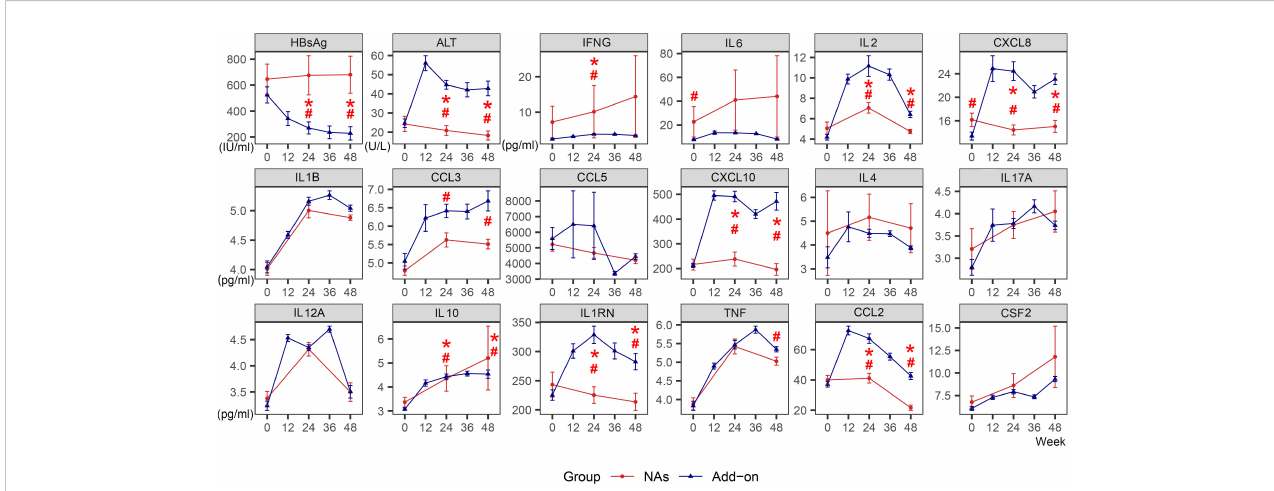
FIGURE 1 Dynamic changes of HBsAg, ALT and cytokines in the NAs group and Add-on group. The line represents the mean and the bar represents the standard error. #, signi fi cant differences in cytokine levels between the two groups, P <0.05; *signi fi cant differences in the amplitude of cytokine change from baseline between the two groups, P <0.05. HBsAg, hepatitis B surface antigen; ALT, alanine aminotransferase; NAs, nucleos(t)ide analogs; Add-on, NAs combined with pegylated interferon alpha